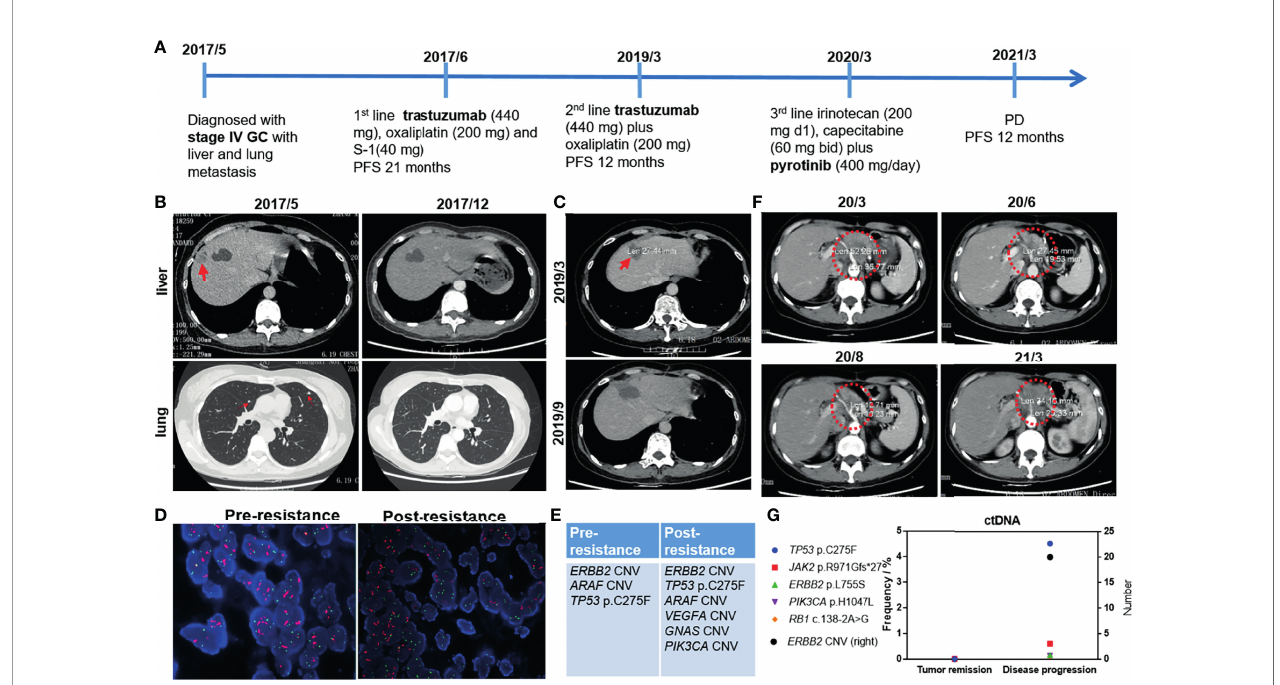
FIGURE 1 | (A) The treatment procedure of the 49-year-old female with stage IV GC. GC, gastric cancer; PFS, progression-free survival; PD, progressive disease. (B) The results of chest computed tomography (CT) scans suggested that liver and lung lesions were reduced in size after fi rst-line treatment. (C) CT results at fi